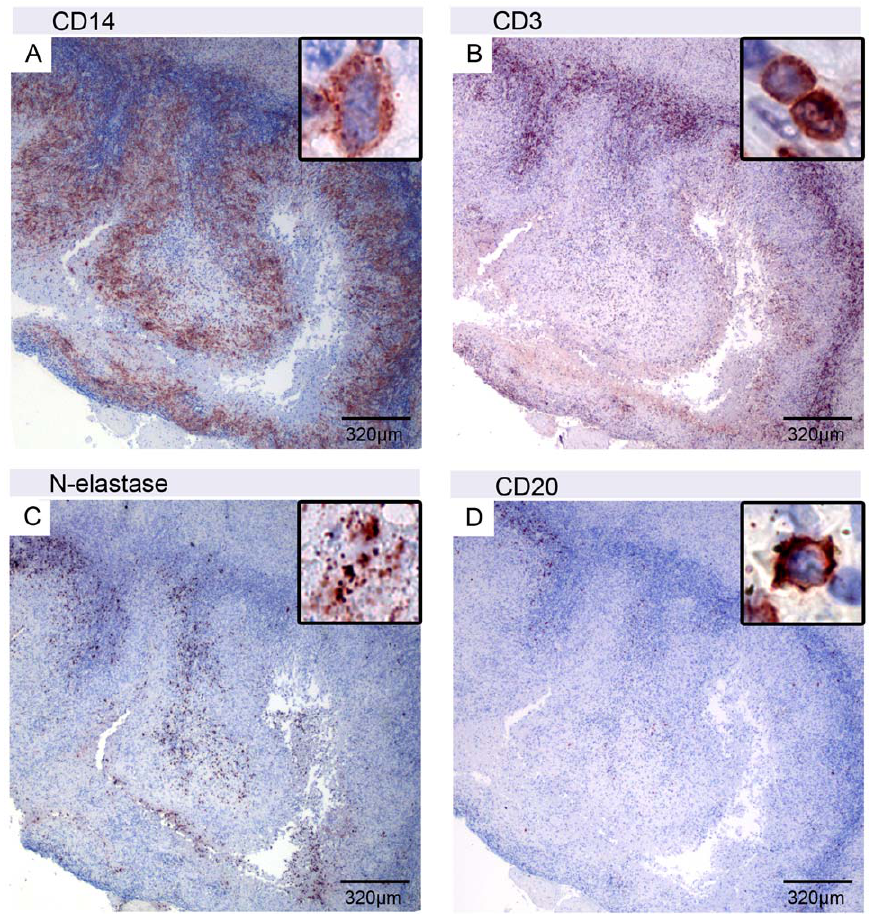
Figure 4. Bands of leucocytes surrounding an uninfiltrated necrotic area. Serial sections of nodule 2 of patient 1 with a necrotic area surrounded by a belt of CD14 positive monocytes/macrophages (A) and a more external second belt of CD3 positive T-cells (B). The necrotic core contained N-elastase positive neutrophilic debris (C), but no intact neutrophils (D insert). Clusters of CD20 positive B-cells were found away from the necrotic core